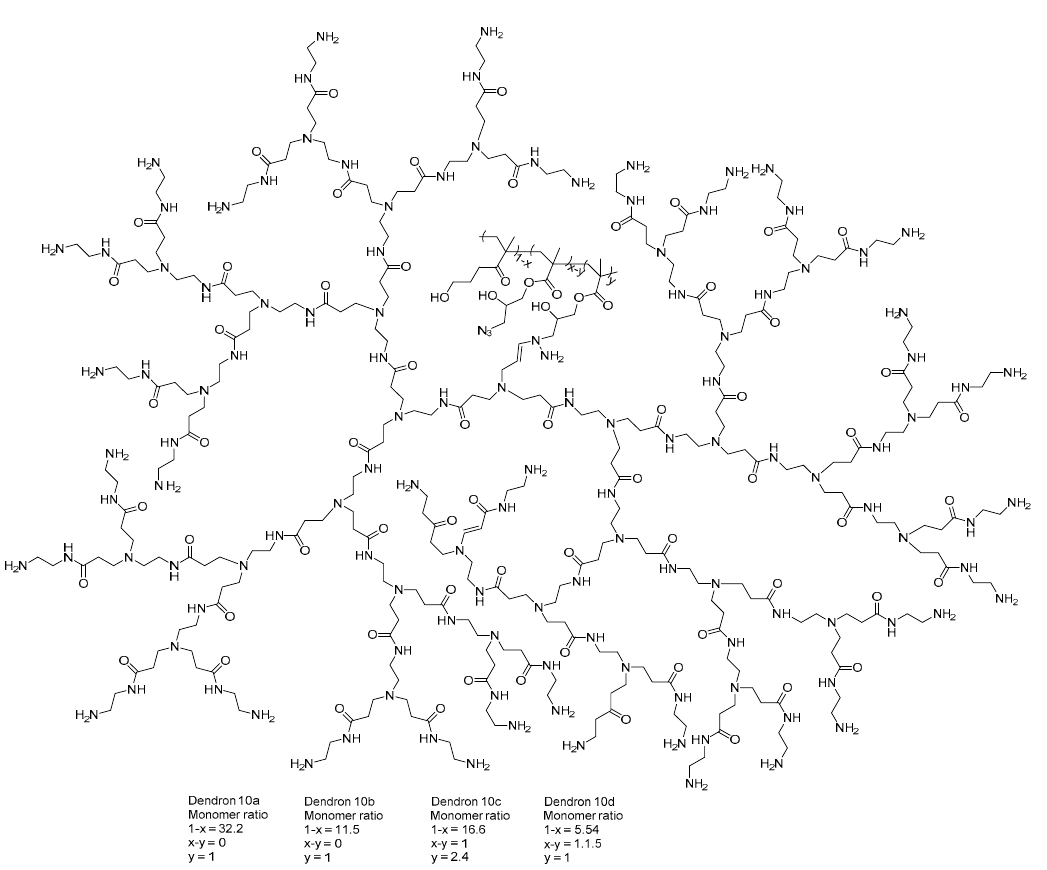
Figure 10. PAMAM-G5 functionalized with linear copolymers for gene delivery as CRISPR (clustered regularly interspaced short palindromic repeats) [92].